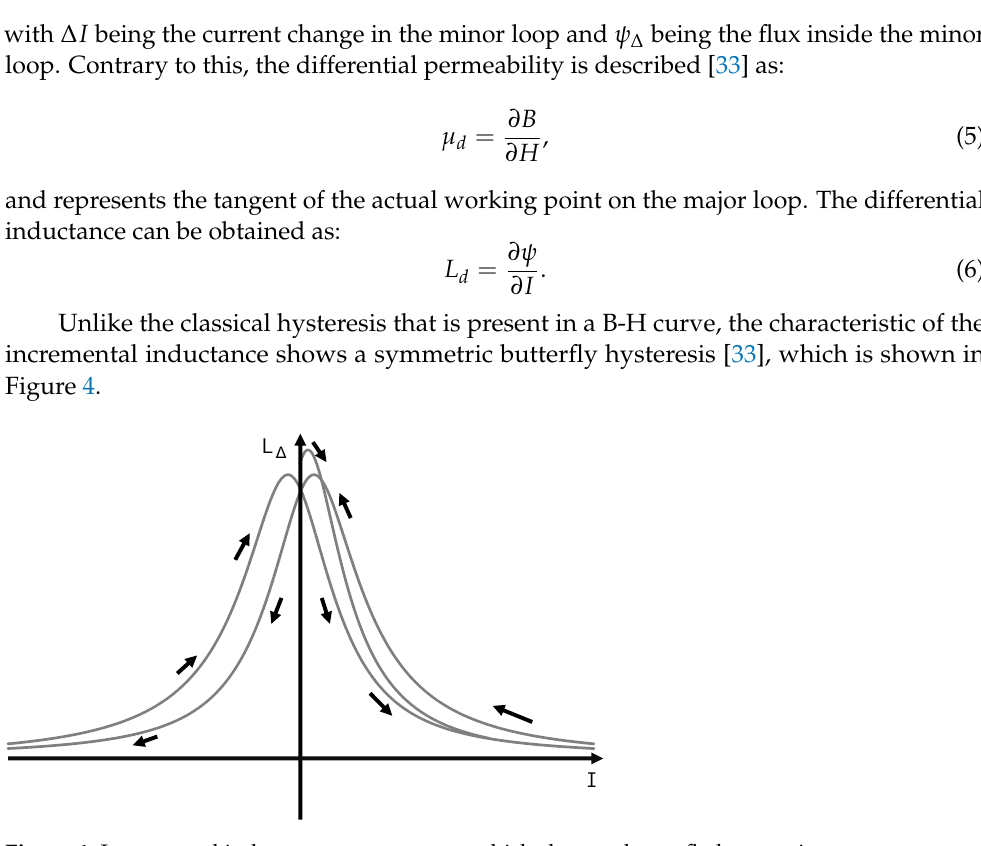
Figure 4. Incremental inductance over current, which shows a butterfly